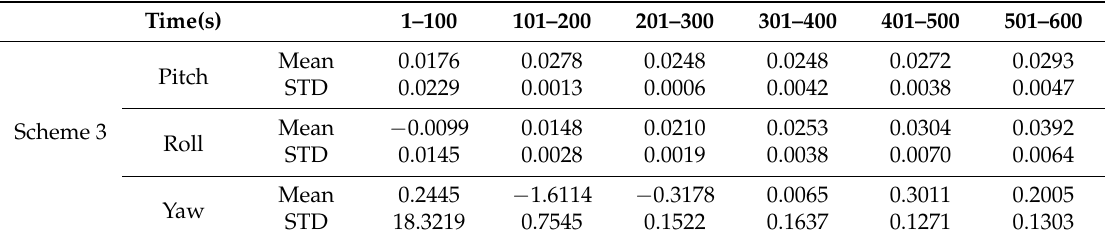
Table 6. The statistics of the alignment errors (°).